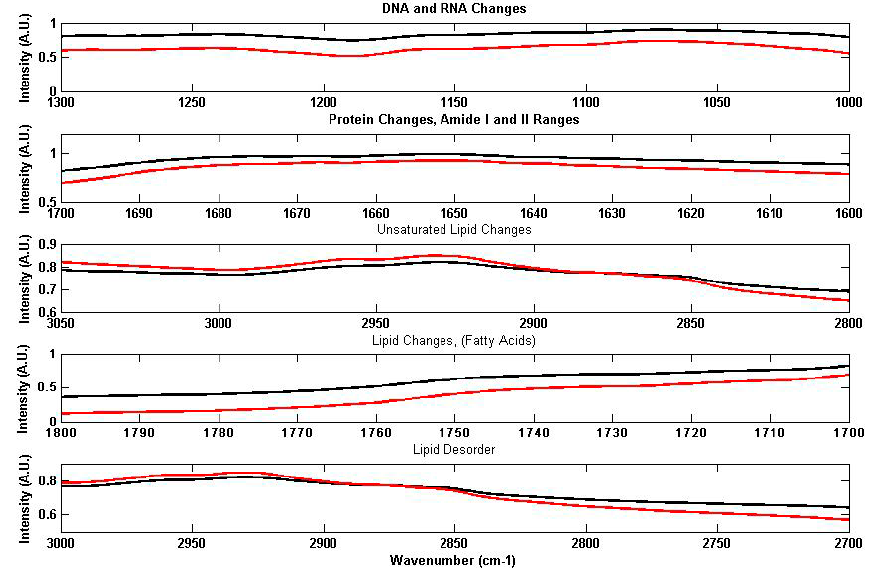
g·L − 1 ) sample in the FTIR spectral range corresponding to the absorptions of the DNA and RNA region; proteins; unsaturated lipids; fatty acids; and lipid disorder. The spectral ranges are reported starting from the top to the bottom plot.